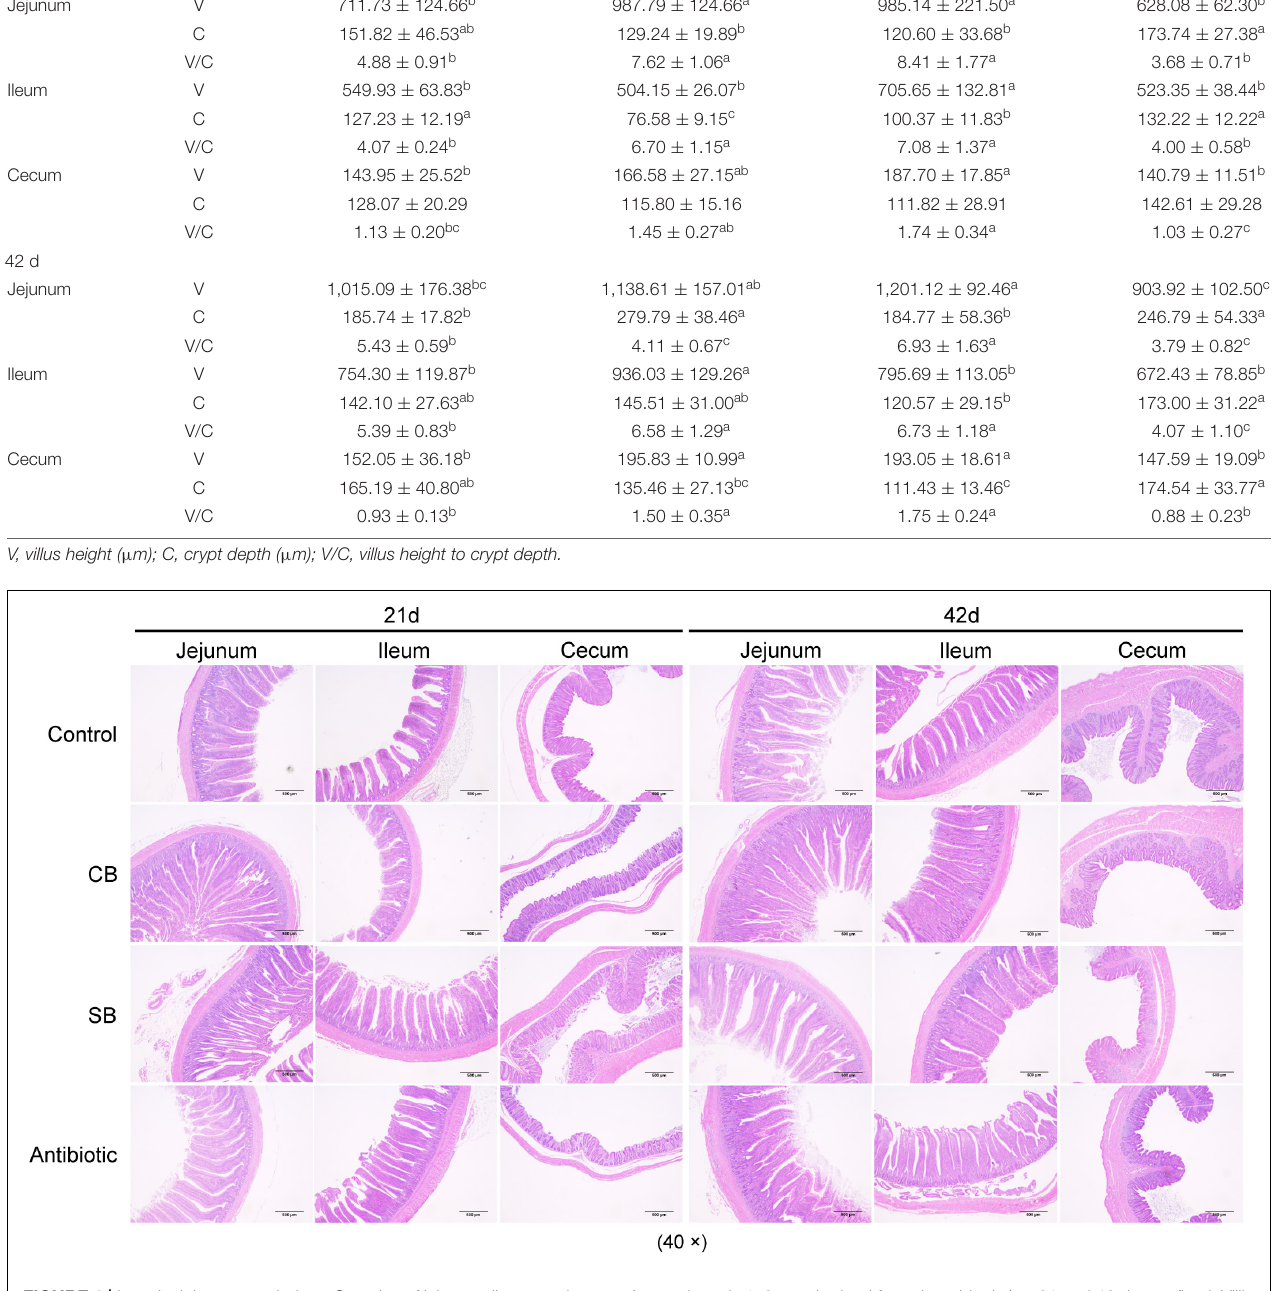
than those in the Control group at all stages ( Figure 2